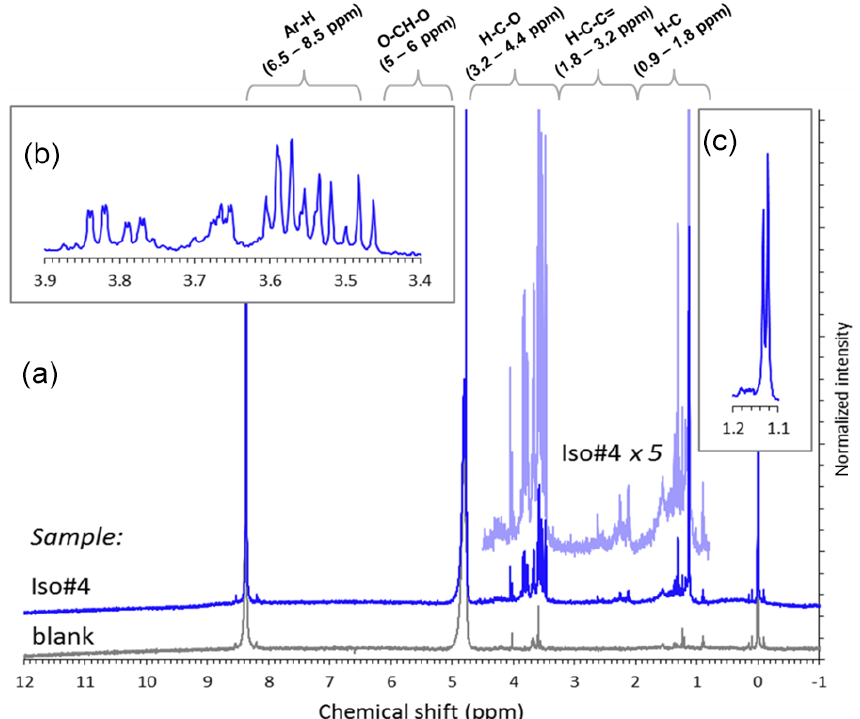
Figure 3. (a) 1 H-NMR spectrum of isoprene SOA generated in the PAM reactor at an OH exposure of 8 × 10 11 moleccm − 3 s. The bottom trace shows the same spectrum with enlarged the broad background bands. Panels (b) and (c) show the methyltetrols resonances between 3.4 and 3.9ppm and 1.12–1.13ppm,